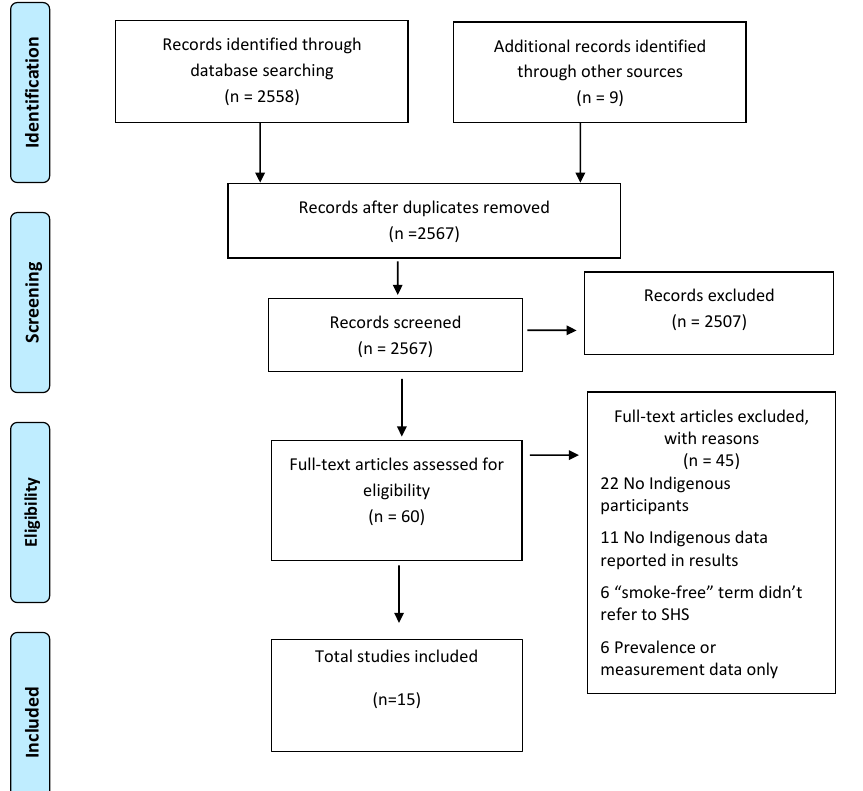
Figure 1. Summary of the article selection process as recommended by the PRISMA statement.